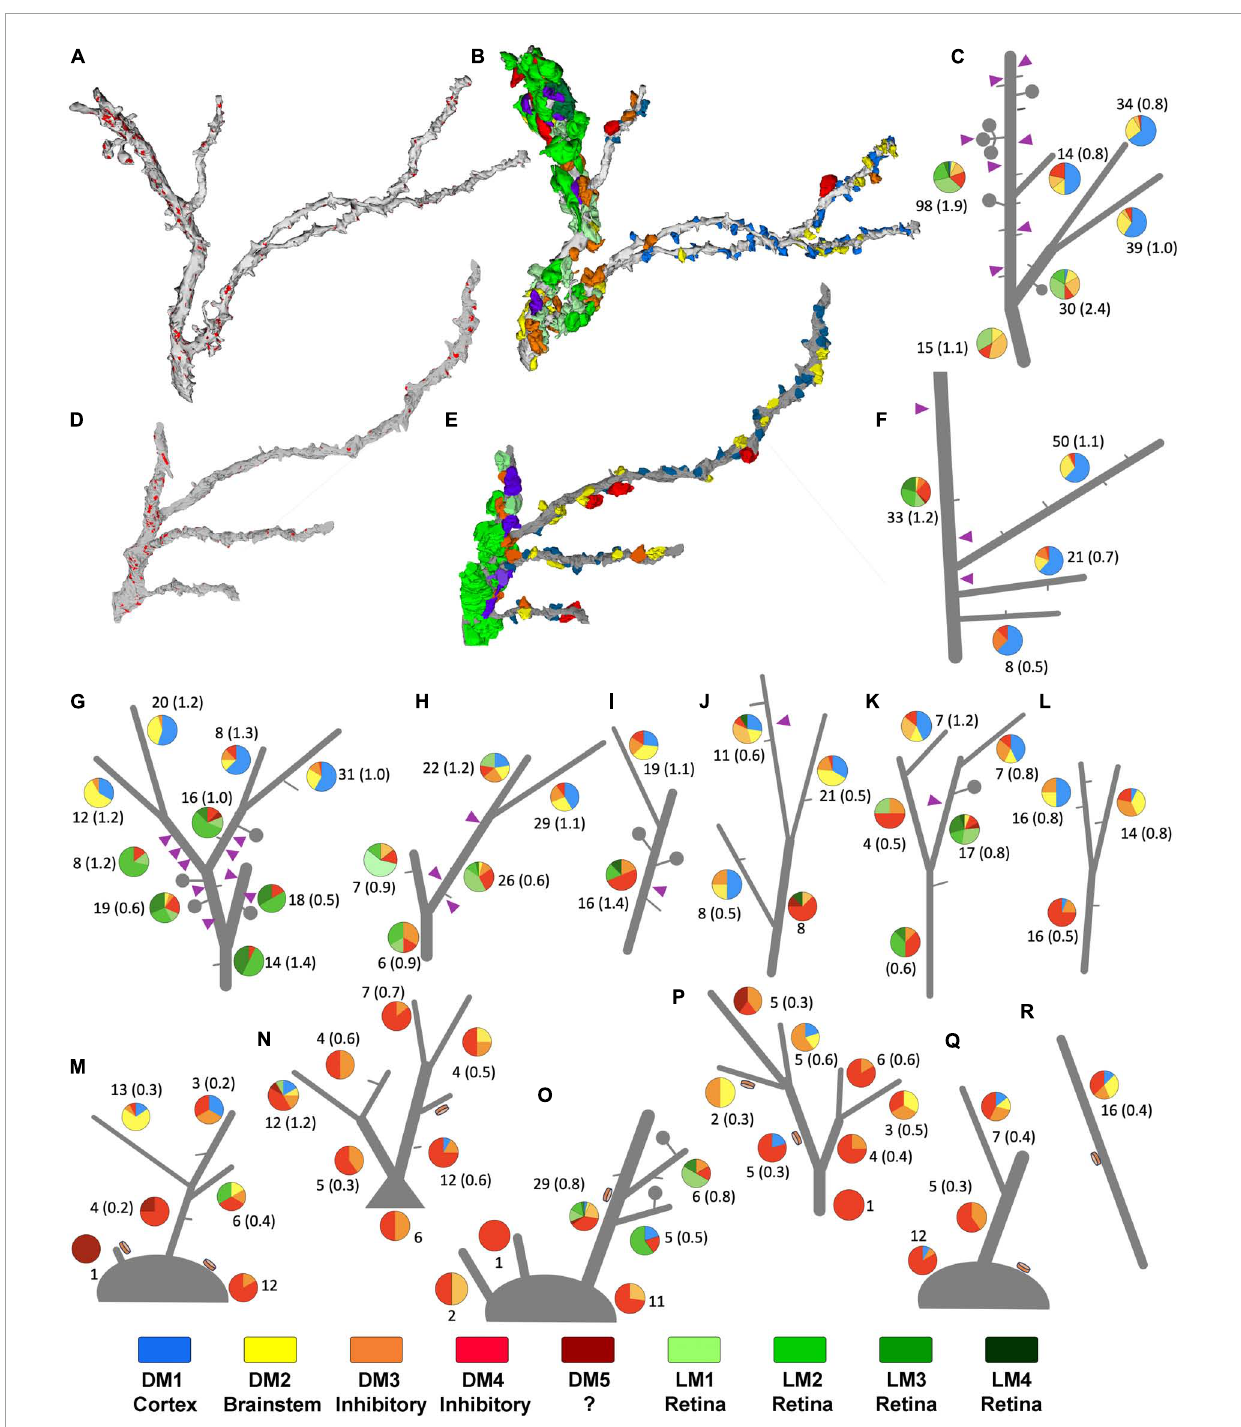
FIGURE6 Sorting of relay dendrites based on exclusive morphological features. (A–F) Two examples of reconstructed relay dendrites and the distribution of boutons on distinct arbor segments. Synapses [red in panels (A,D) ], and volume-sorted bouton subtypes (B,E) are illustrated on dendrite reconstruction (gray). The color scheme for volume-sorted boutons in panels (B,E) matches Figures 1 , 5 , and the legend at the bottom of this Supplementary Figure 2 boutons that partake in triads are colored purple regardless of their volume-sorted subpopulation. Stick figures of dendrites (C,F) are used to illustrate the contribution of each volume-sorted bouton subpopulation on distinct arbor segments (pie charts- legend at the end of the figure applies). The numbers under each pie chart indicate the number of boutons that synapse on a particular dendrite segment and the frequency of synapses (in parenthesis) along the length of that segment. Purple triangles indicate the approximate location of a triad. (G–R) While many reconstructed relay dendrites in our dataset displayed filopodia (short gray lines) and spines/grape-like appendages (lollipops), only a group received synapses from F2 type terminals (purple triangles) forming triads. (G–K) In contrast, others displayed dendrodendritic PA (orange disks) and sparse filopodia (M–R) . While processes that can be classified as spines were also occasionally encountered on this second group, no triads were found. The dendrites engaged in triads at any of their segments are categorized as X-type, and those display a PA are categorized as putative Y-type relay dendrites. Dendrite l was uncategorized for the network